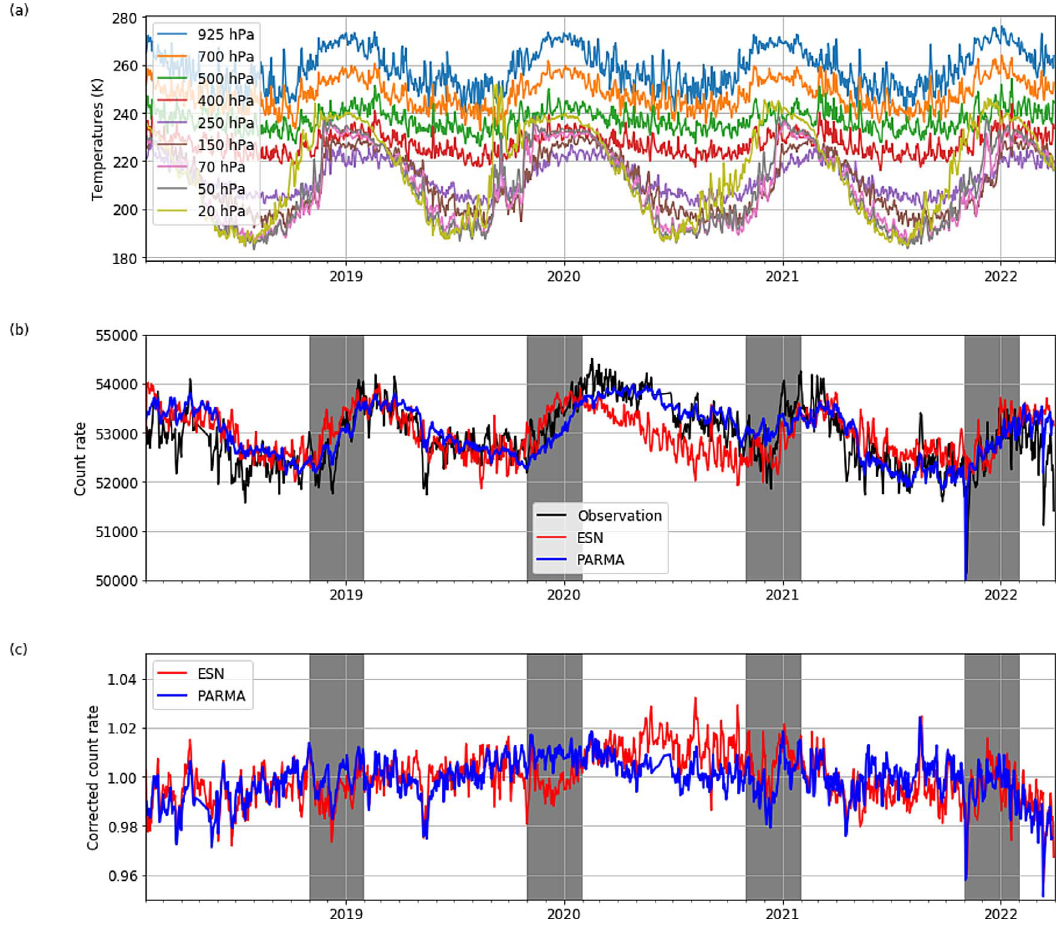
Figure B3. Same as Figure 4 except for the time resolution, using 24 h values ( N =